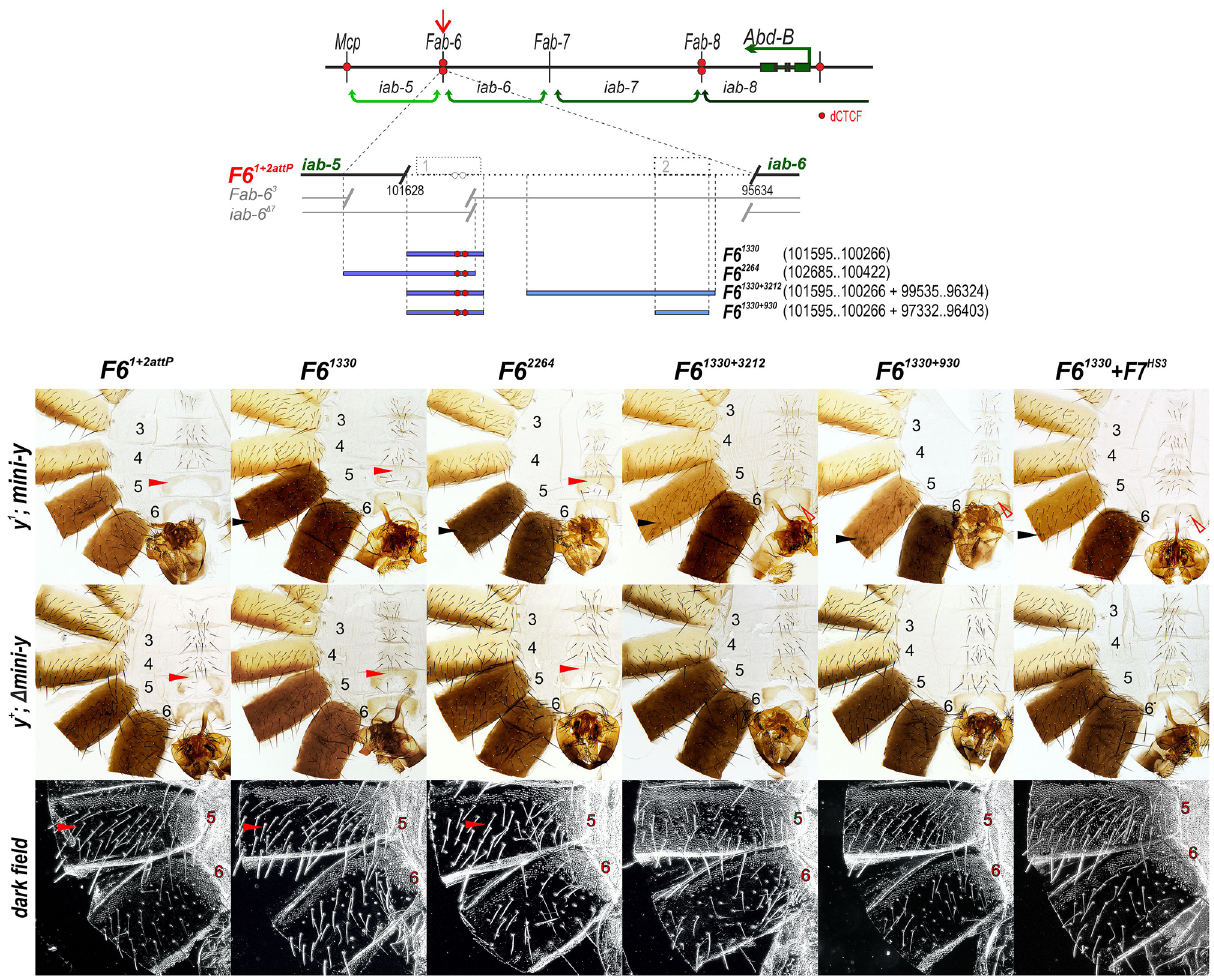
Figure 4. The Fab-6 HS2 cooperates with HS1 to reconstitute a fully functional boundary. On the top: schematic diagram of the Fab-6 region, the F6 1 + 2attP deletion and the different DNA fragments tested for boundary activity. Morphology of the male abdominal segments in males carrying different Fab-6 fragments in F6 1 + 2attP . All other designations are the same as described in Figs. 1 and